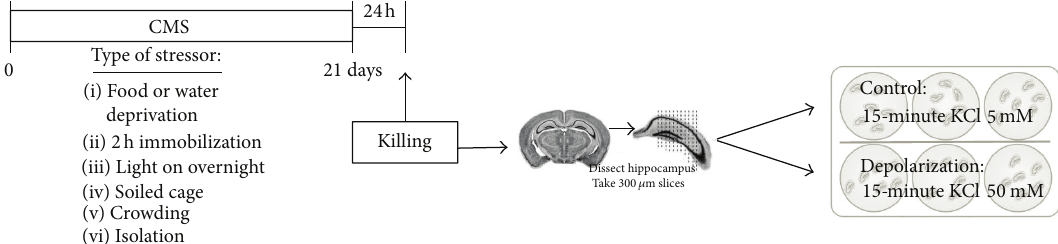
Figure 1: Experimental paradigm. Adult male Sprague Dawley rats were subjected to the stress procedure for 3 weeks and then sacrificed by decapitationafter24hoursfromthelaststressor.Thebrainswererapidlyremovedforhippocampalslicespreparation. Theslices,afteraperiod ofadaptationinoxygenatedKrebsbuffer,wereincubatedfor15minutesinpresenceorabsenceofKCl50 mMtotesttheeffectsof exvivo depo- larization. After the incubation period, hippocampal slices were collected, frozen on dry ice, and stored at − 80 ∘ C until the molecular